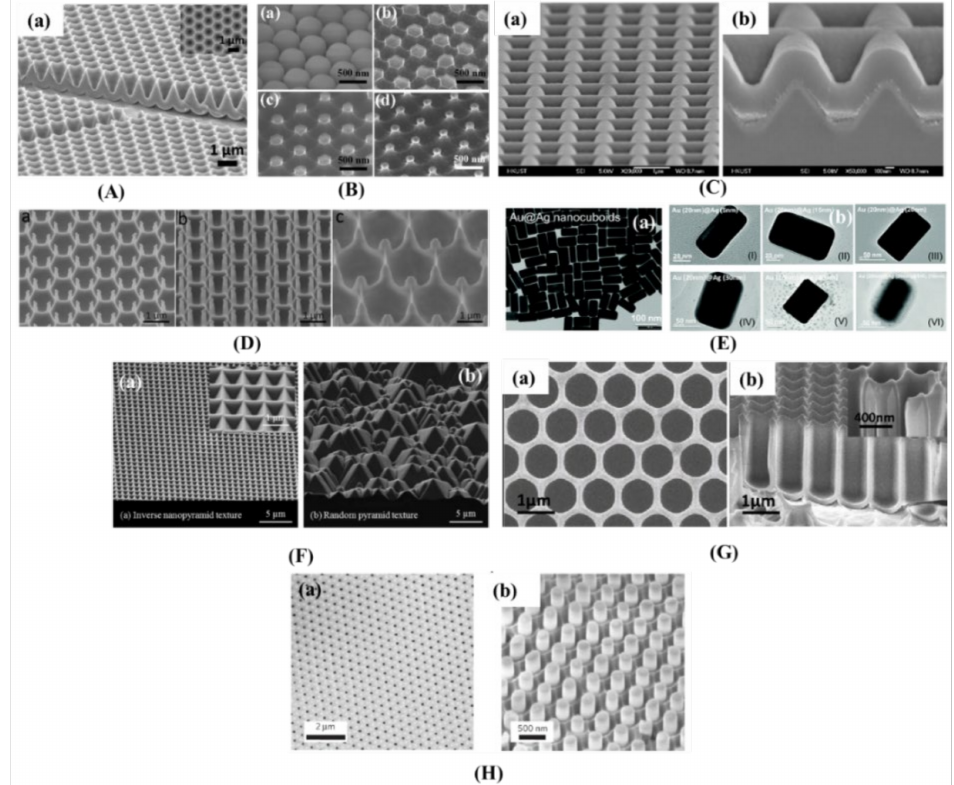
Figure 7. ( A ). ( a ) SEM of Au nanocone-coated template with 1 µ m pitch and 1 µ m depth